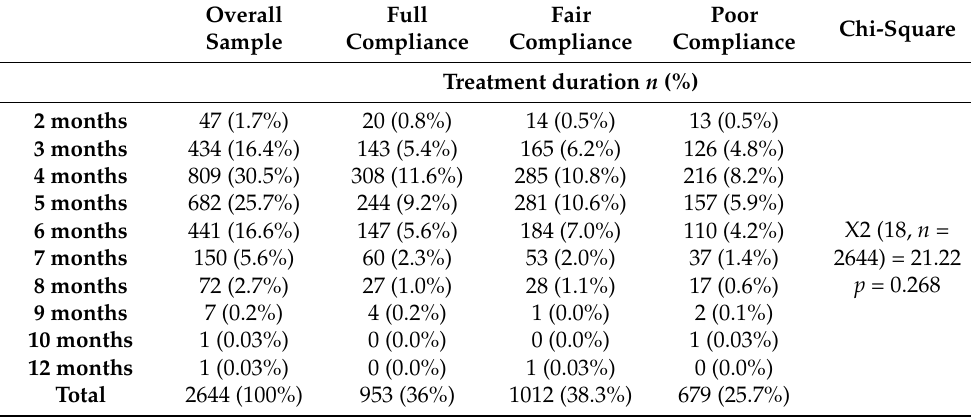
Table 3. Comparisons of compliance by treatment duration.